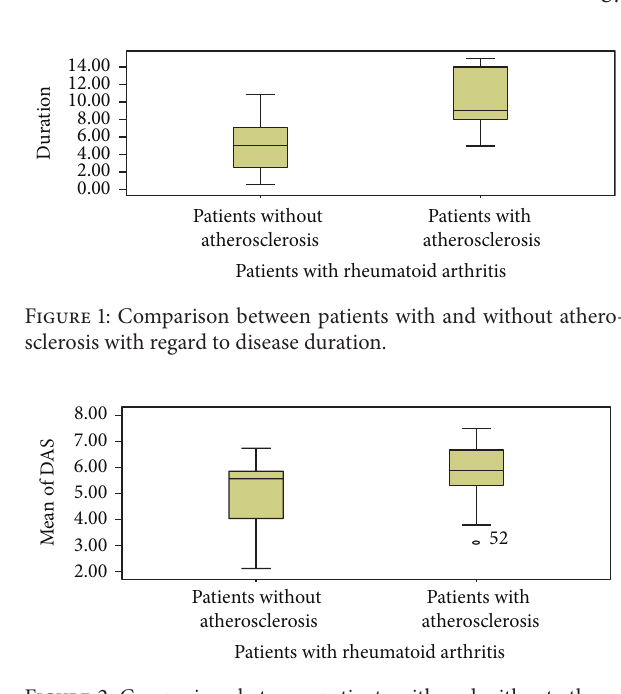
Figure 2: Comparison between patients with and without athero- sclerosis with regard to disease activity. Table 4: Comparison of ultrasonographic duplex findings in RA patients and controls.